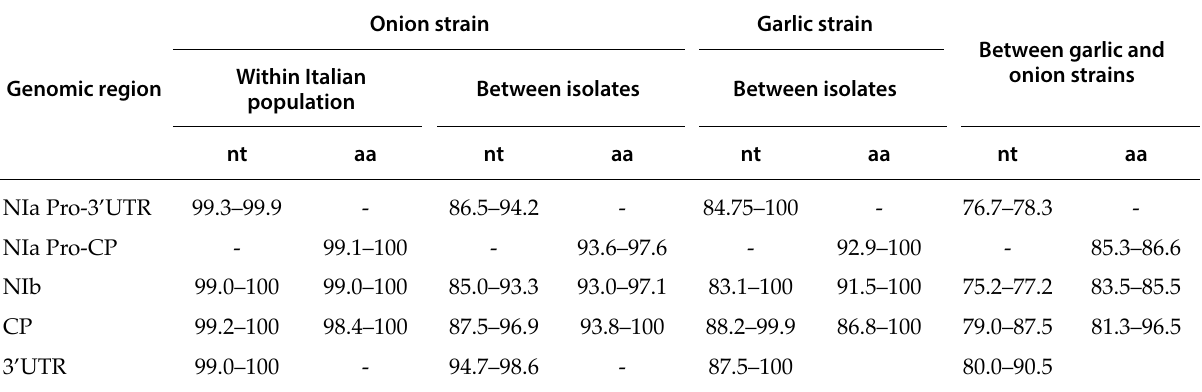
Table 3. Range of nucleotide and amino acid sequence identities (%) in the studied genomic regions within OYDV-O popu- lations, OYDV-G populations, and between OYDV-O and OYDV-G. Comparisons were performed using all the Italian isolates and the Sudanese isolate from this study, and all available sequences for each compared region retrieved from the GenBank and reported in the phylogenetic